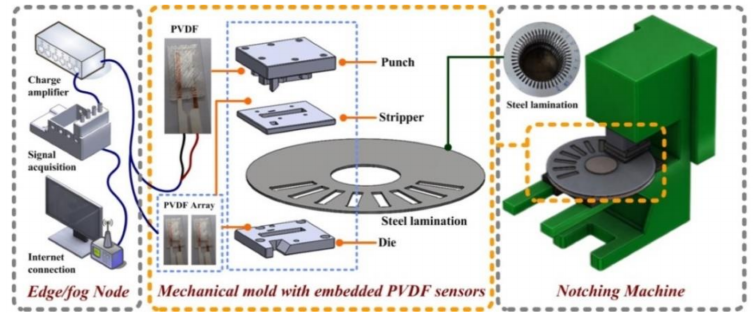
Schematic illustration of proposed cyber-physical systems- polyvinylidene fluoride (CPS-PVDF) online monitoring system: PVDF mechanical films with embedded sensors provided contact force measurements from notching machine as an indication of tool